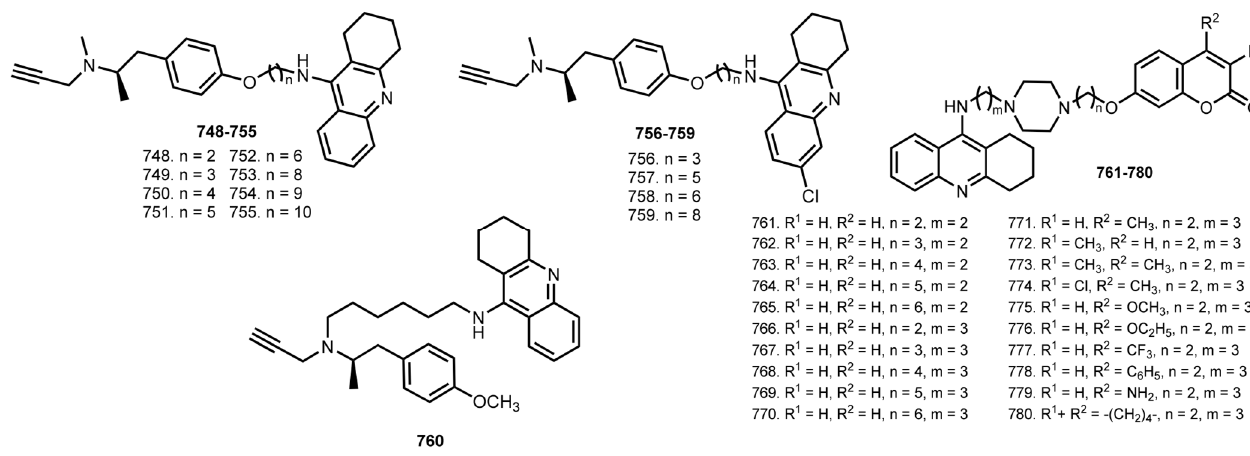
Figure 31. THA–selegiline hybrids 748 – 760 [111], THA–coumarin hybrids 761 – 780